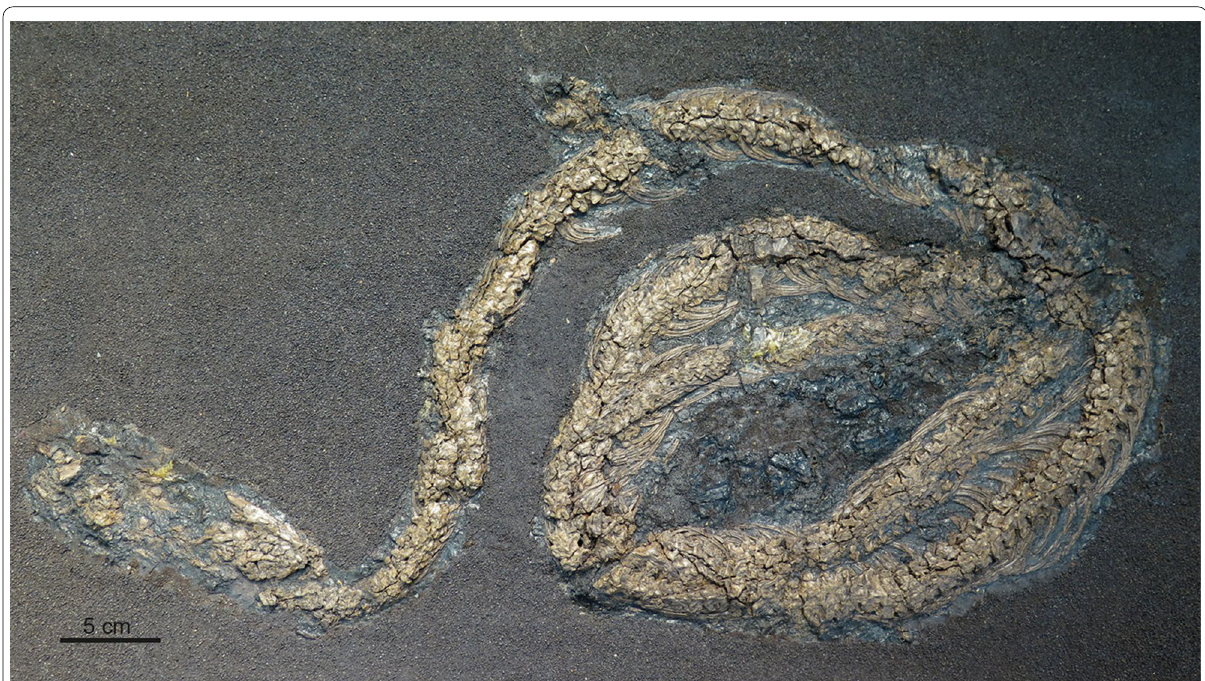
Fig. 29 Palaeopython ceciliensis from quarry Cecilie III, Geiseltal: articulated, 2.3 m, skeleton with crushed skull and 243 vertebrae (GMH Ce III-5867-1933). This specimen was originally figured by Kuhn (1939a:pls. I.3 and II.3), Weigelt (1934:pl. IX.1), and Krumbiegel et al. (1983:fig. 114). Referral to the species is probable, though not